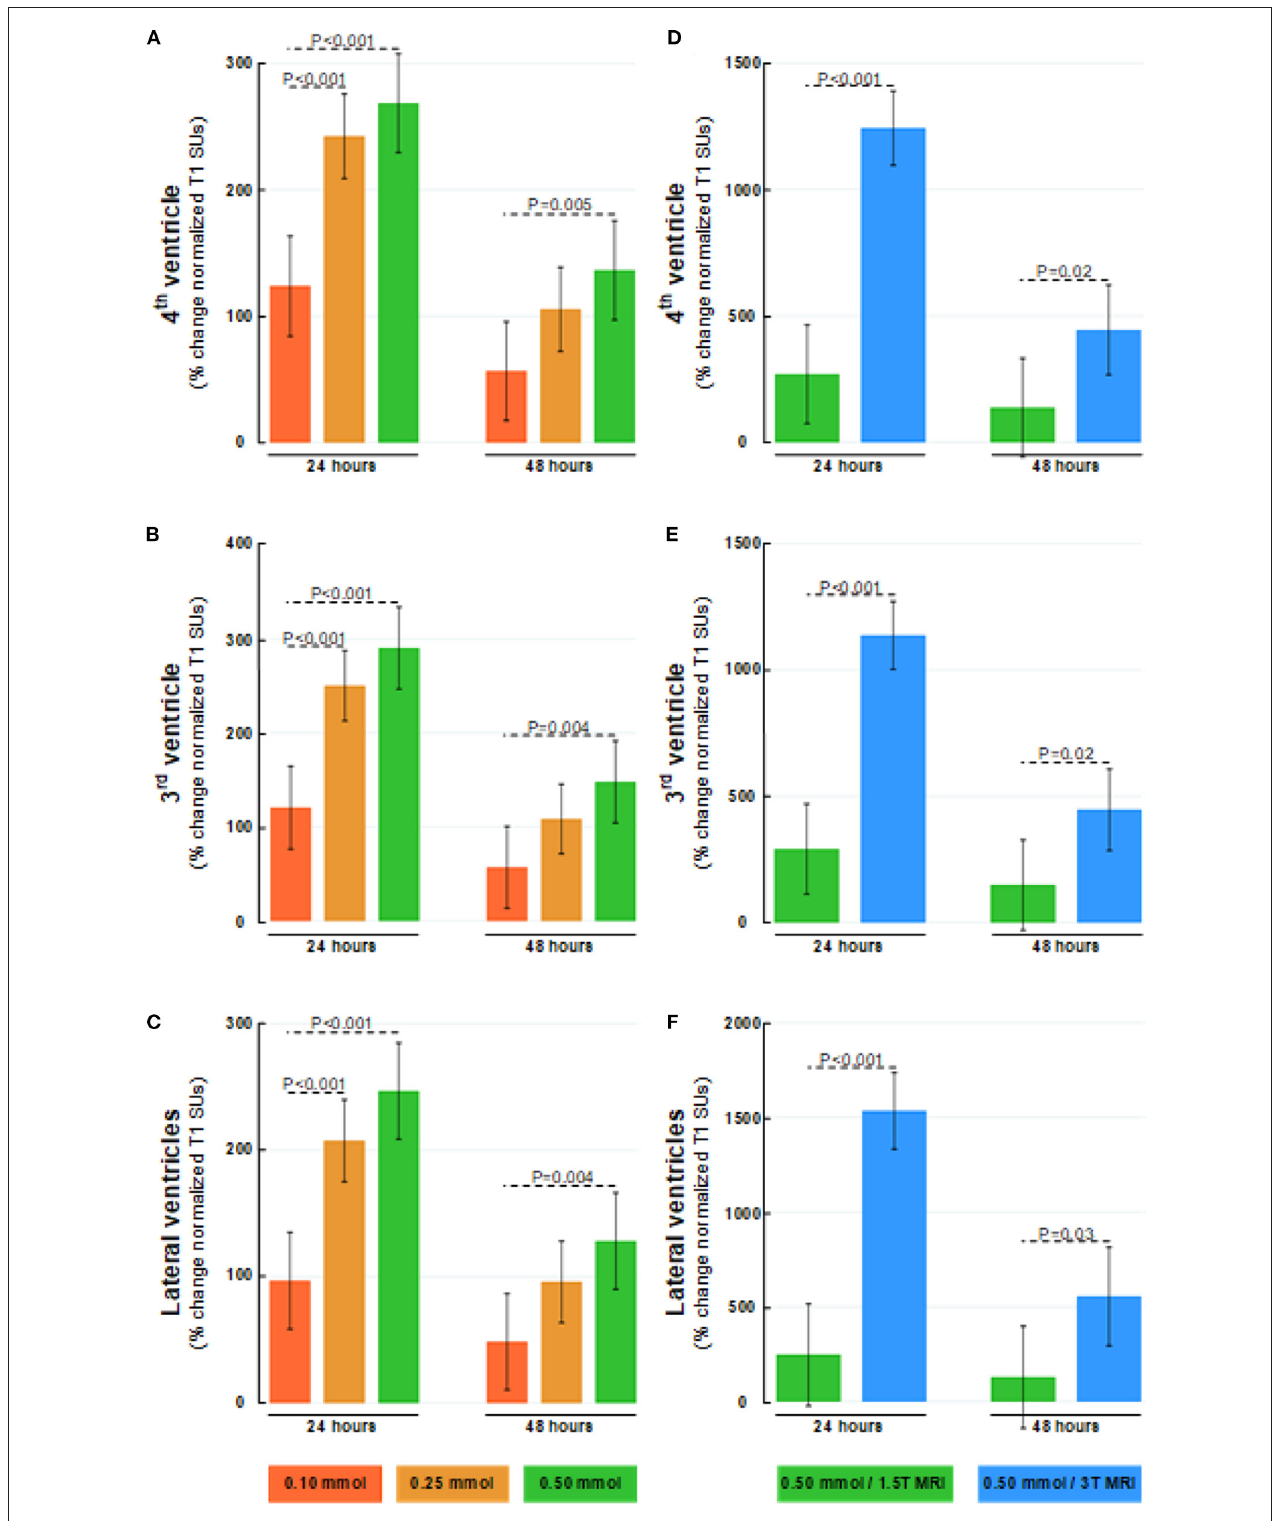
FIGURE 5 | Dose-dependent percentage changes in normalized T1 signal (1.5T MRI scanner) after 24 and 48h are shown for (A) 4th ventricle, (B) 3rd ventricle, and (C) lateral ventricles following intrathecal gadobutrol in doses of 0.10 (red bars), 0.25 (orange bars), and 0.50 mmol (green bars). The percentage change in normalized T1 signal at 24 and 48 hours after intrathecal gadobutrol (0.50 mmol) within (D) 4th ventricle, (E) 3rd ventricle, and (F) lateral ventricles are shown for 1.5T (green bars) and 3T MRI scanners (blue bars). The bars show mean and 95% CIs. Differences between groups were determined by mixed model